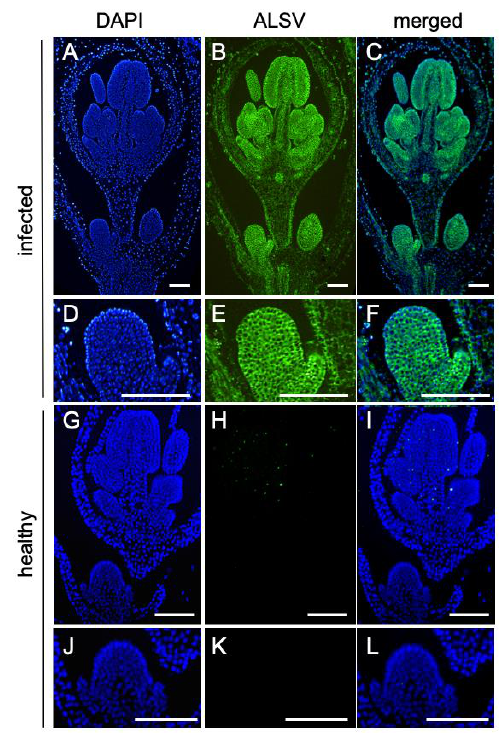
Figure 2. ALSV localization in floral buds of S. latifolia plants. ( A – F ) Flower buds infected with ALSV and ( G – L ) uninfected healthy flower buds. ( A , D , G , J ) Nuclei stained with 4′,6-diamidino-2-phenylindole (DAPI), ( B , E , H , K ) ALSV, detected by Fluorescein-5-isothiocyanate (FITC), and ( C , F , I , L ) their merged images. ( A – C ) Infected flower buds at a late stage and ( D – F ) enlarged images of the infected flower buds at an early stage. ( G – I ) Healthy flower buds at an early stage and ( J – L ) enlarged images of the healthy flower buds at an early stage. Representative images of at least three individual plants are shown. Bars = 100 µm.